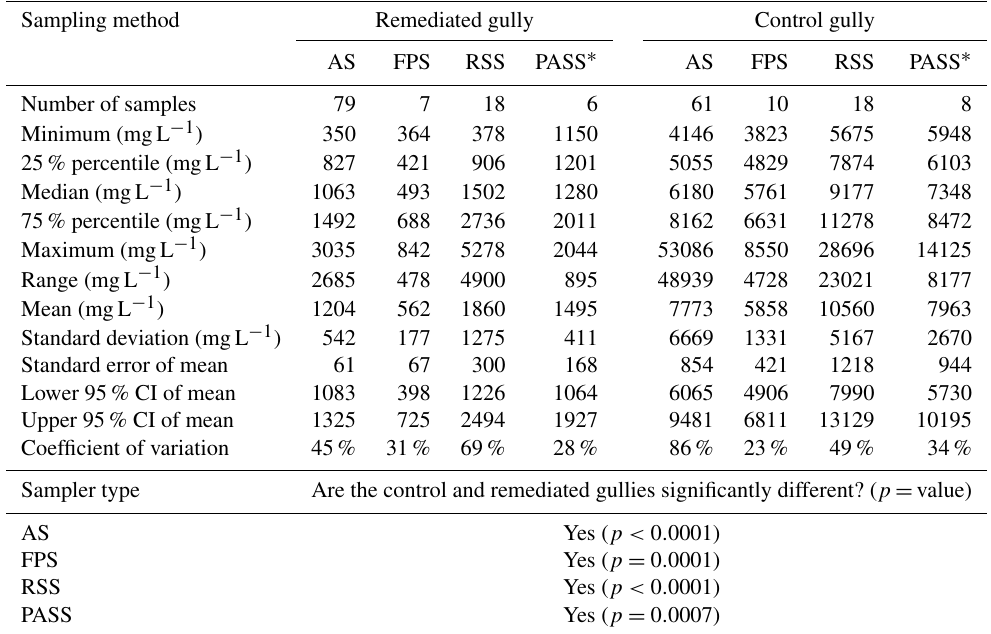
Table 2. Descriptive statistics of SSC samples collected from the control and remediated gullies during the 2017–2018 and 2018–2019 wet seasons.